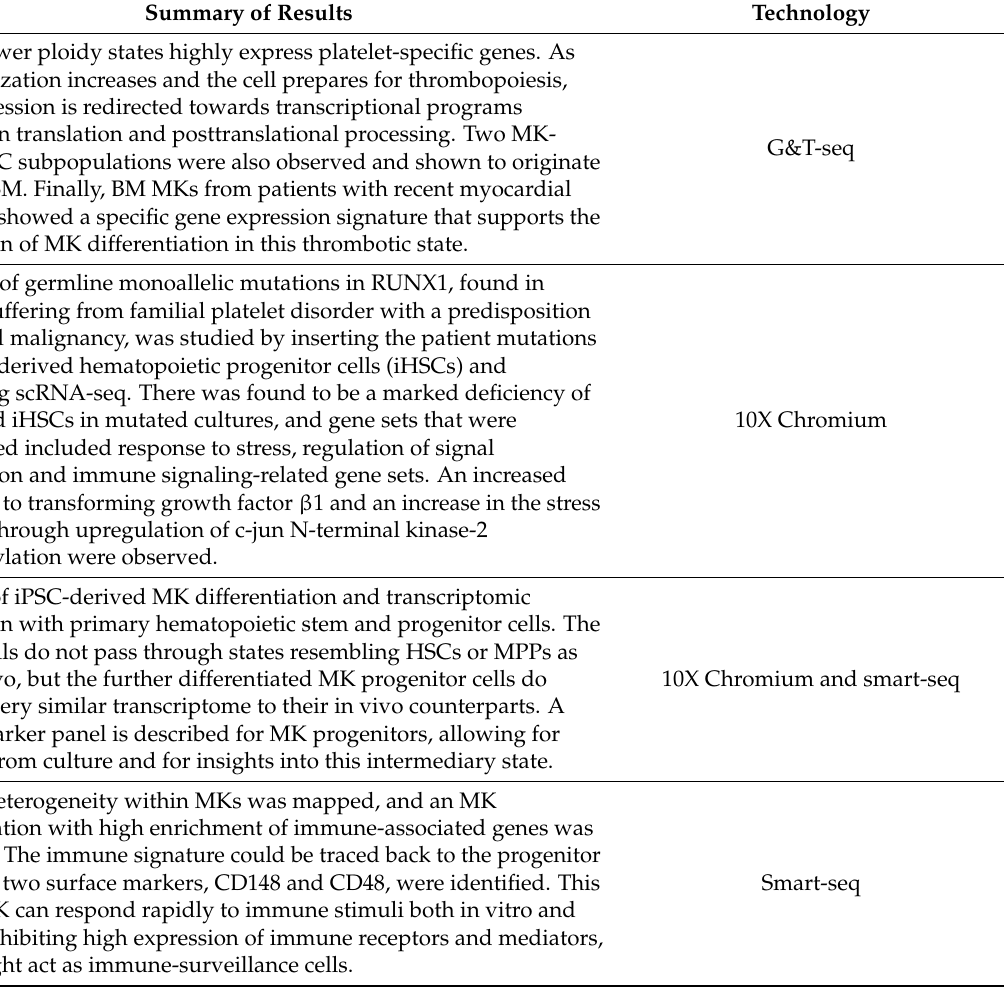
Table 2. scRNA-seq research in megakaryocytes and precursors in